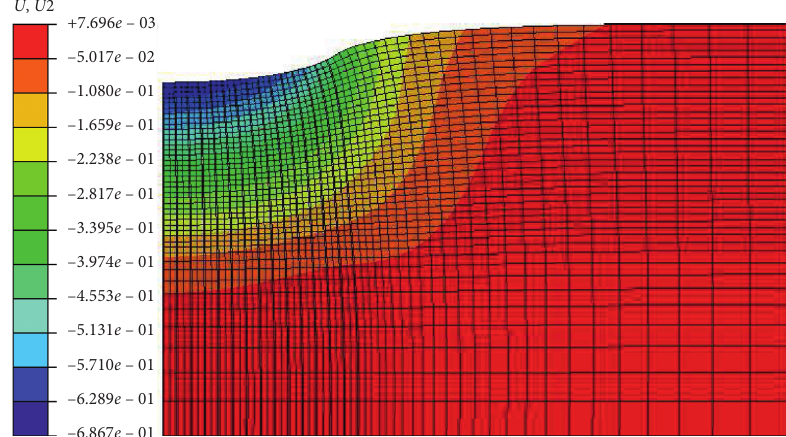
Figure 7: Settlement contour by finite element